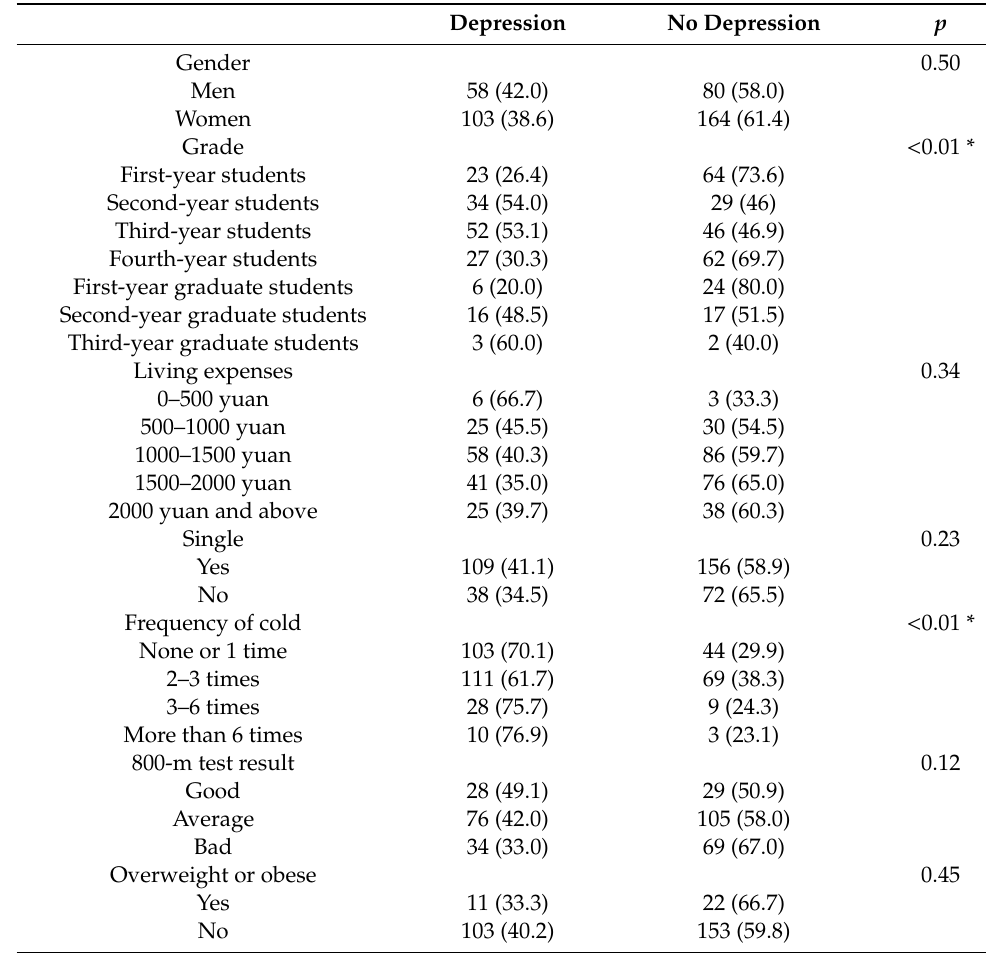
Table 3. Sociodemographic and physical health characteristics of participants.